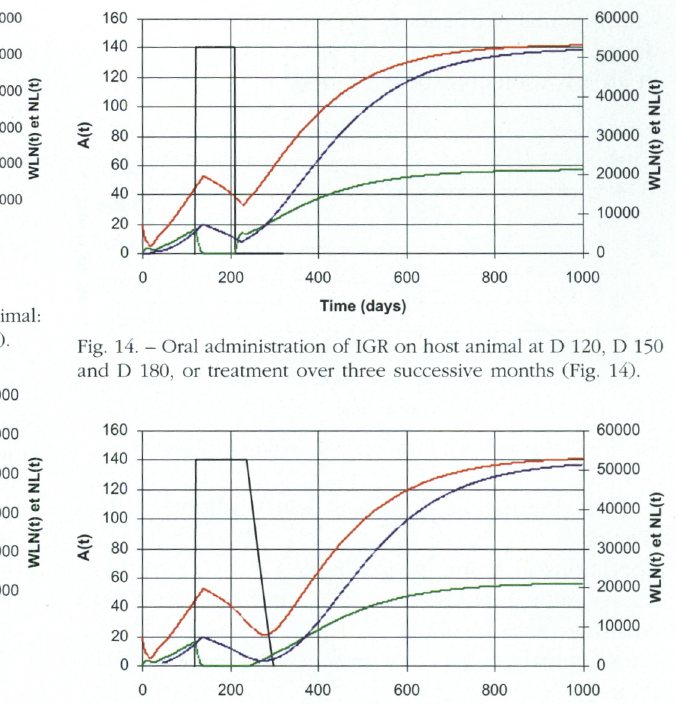
Fig. 12. - Application of persistent insecticide to host animal: single treatment applied at D 120.